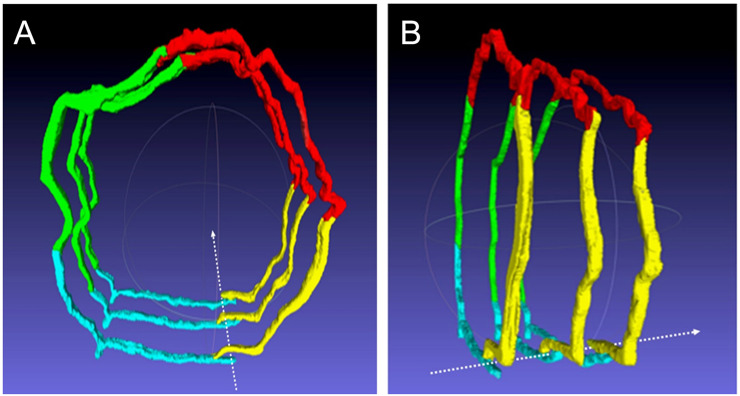
Starting from the black/white model, color models where obtained to better explain the main steps of the ETC phenomenon (A, B). These models together uniquely and properly resembled the endothelial cells behavior during intravasation of a neoplastic cell. Frontal (A) and lateral (B) views of the color models; the dashed white arrow indicates the path of a TCi crossing the endothelium. The four different endotheliocytes composing the endothelial wall are shown (cyan, green, red, yellow).